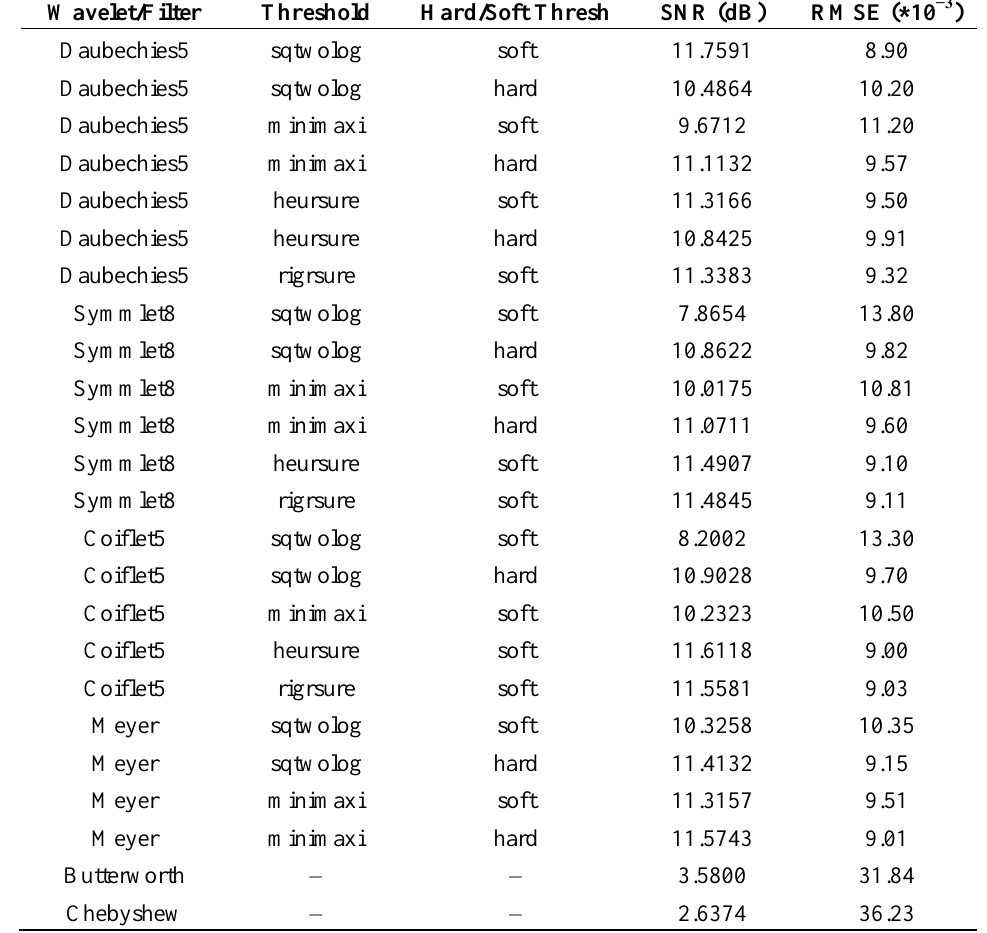
Table 2. Results of simulated EMG signal